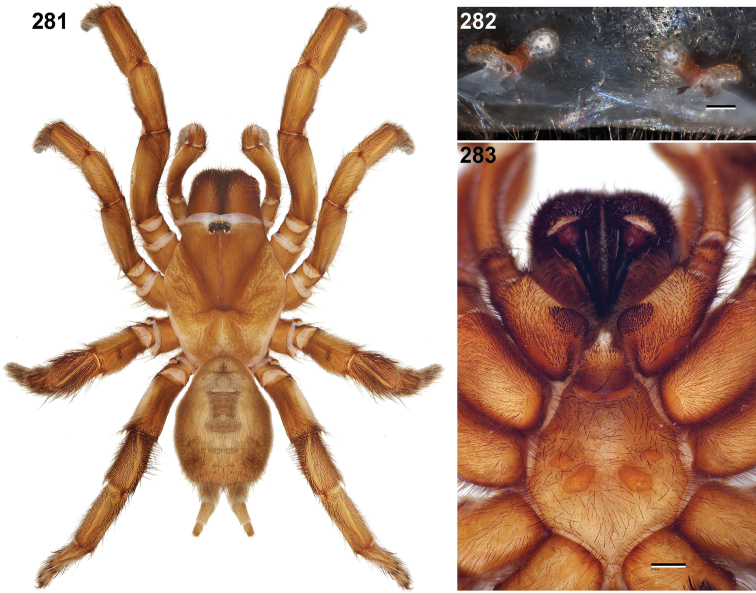
Aptostichus simus female specimens. 281 habitus, from San Diego County (AP067) 282 cleared spermathecae (MY3447), from San Luis Obispo County [806538]; scale bar = 0.1mm 283 cephalothorax, ventral aspect, from San Diego County (AP095) [806542].